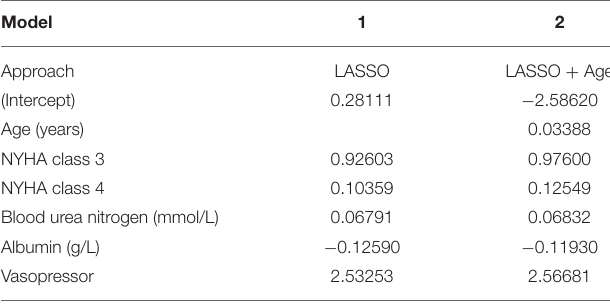
TABLE 2 | Variables and regression coefficients of the two models.